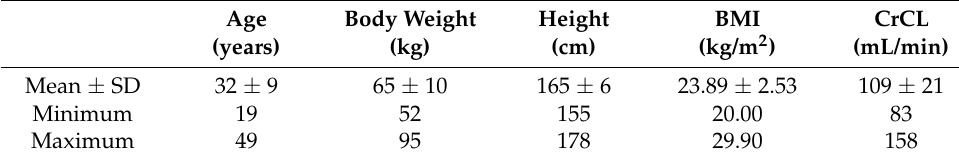
Table 1. Characteristics of the healthy women who participated in the